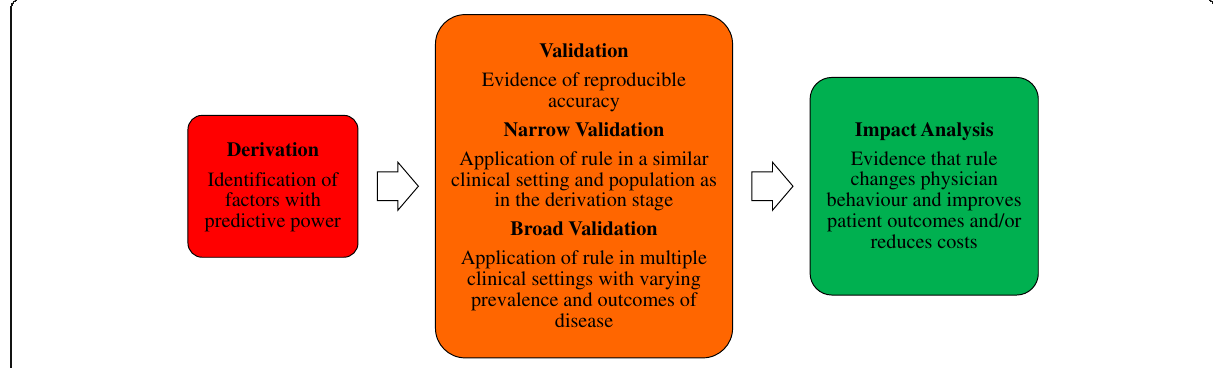
Fig. 1 The three main stages in the development and evaluation of clinical prediction rules. Adapted from McGinn, 2016